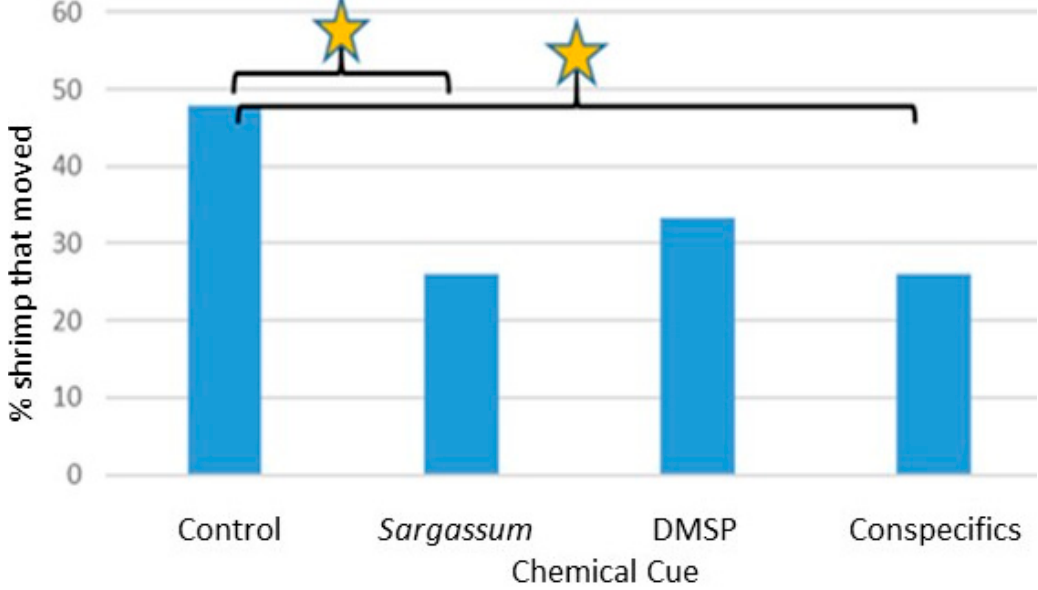
Figure 8. Number of Leander tenuicornis female shrimp that moved out of area C in the Y-maze for the control, Sargassum , DMSP, and conspecific cue trials (binomial test; Sargassum , p = 0.02; DMSP, p = 0.05; and conspecifics, p = 0.01). Star/bracket indicates significant differences between indicated paired groups.